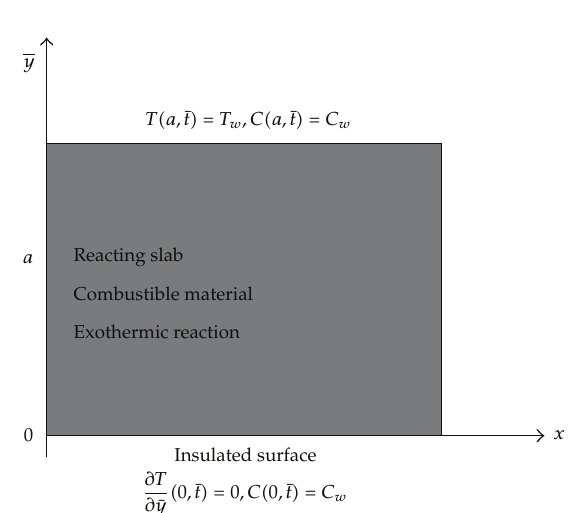
Figure 1: Geometry of the